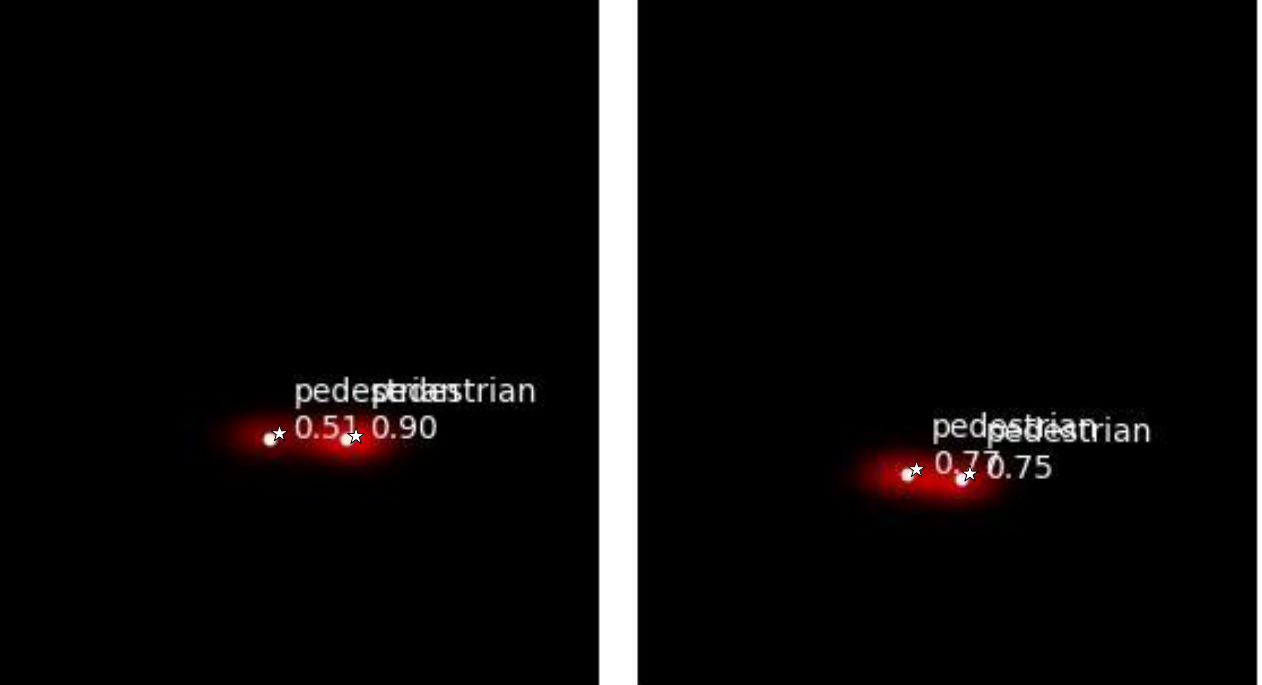
Figure 19. Detection results with labels. Circles represent the test result, and stars represent the true value of the ground.